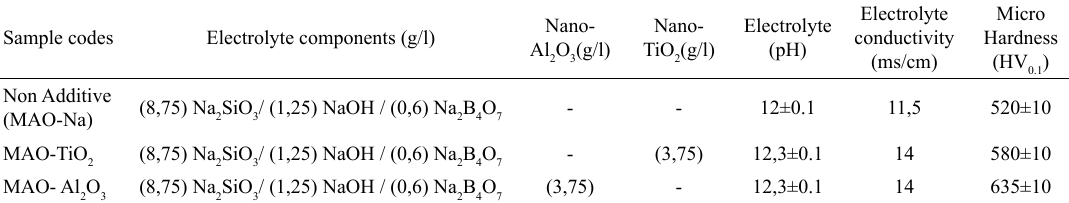
Table 1. MAO coated samples and characteristics of their coating electrolyte Sample